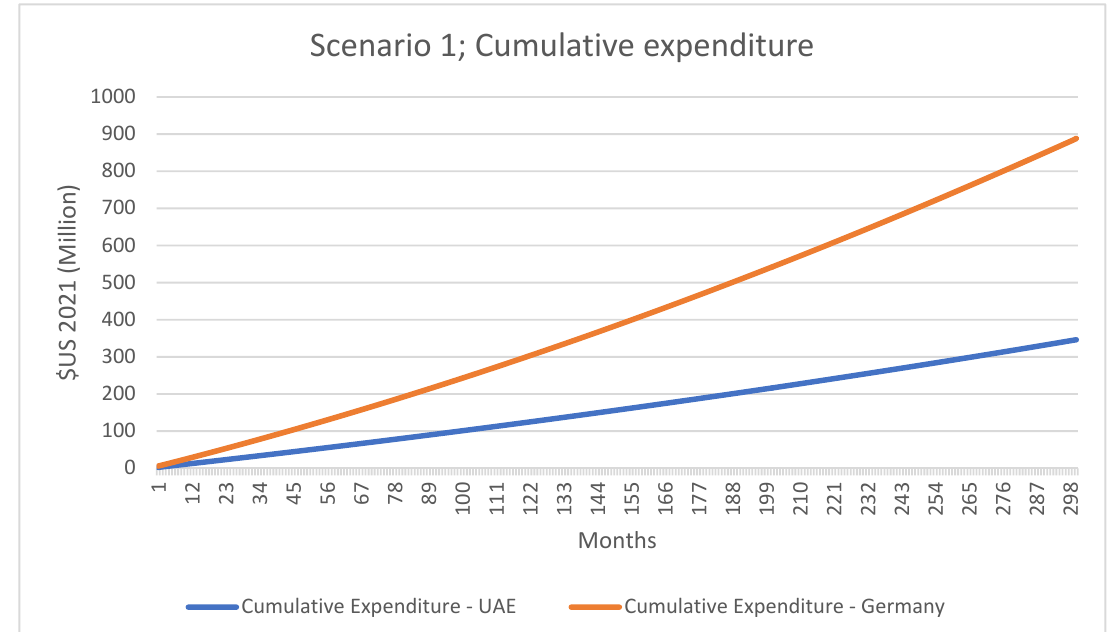
Figure 7. Cumulative emissions through electricity consumption for UAE and DE under scenario 1. The cumulative expenditure in Figure 8 shows similar trends, with a typical cement plant in DE spending 61% more than a similar plant in UAE.